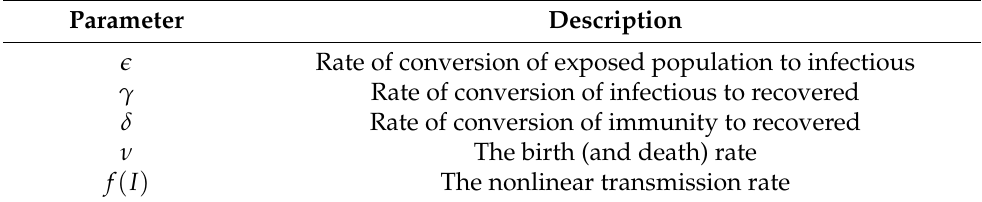
Table 1. Description of the